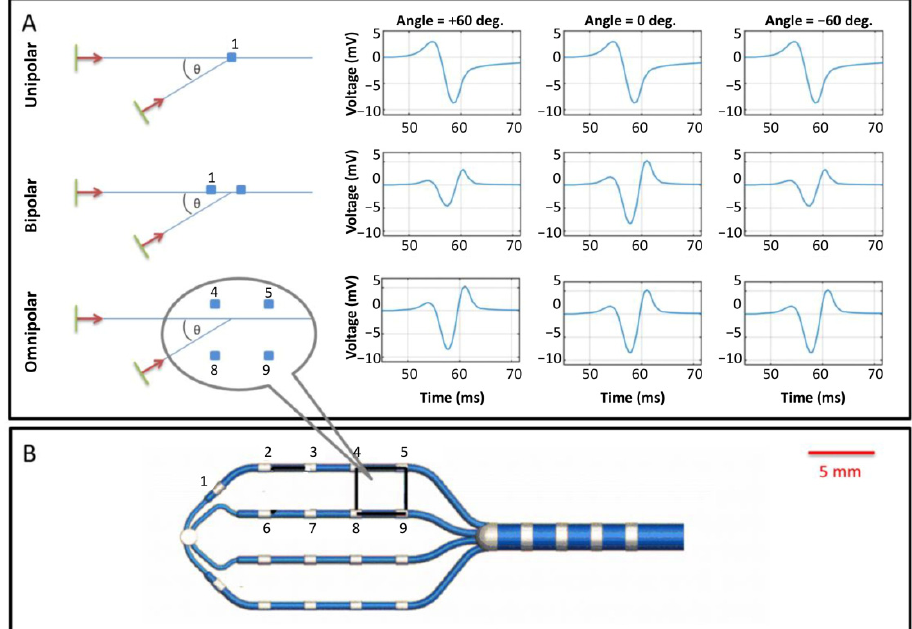
Figure 3. Schematic of intracardiac electrogram recording. ( A ) Illustration of directional ambiguity and amplitude dependence of unipole, bipole, and omnipole. Unipolar signals are independent of a direction of wavefront propagation (top row). Bipolar signals depend strongly on the direction of wavefront direction but cannot distinguish between opposing directions (middle row, compare +60° and − 60°). Omnipolar recordings provide identical waveforms regardless of direction (bottom row); however, unlike unipolar recordings, they also provide the direction of propagation (not shown). ( B ) An omnipole design, here consisting of a planar array of 18 electrodes on four splines with a same-spine inter-electrode spacing of 4 mm, and four more electrodes along the catheter’s shaft. Among the many possible electrode pairings, one convenient arrangement consists of a 3 × 3 arrangement of nine rectangular pairings, one of which is illustrated here as 4, 5, 8, 9. The planar array inter-electrode spacing of this design is 4 mm. The figure is reproduced with permission from Deno, D.C. et al. Orientation-independent catheter-based characterization of myocardial activation. IEEE